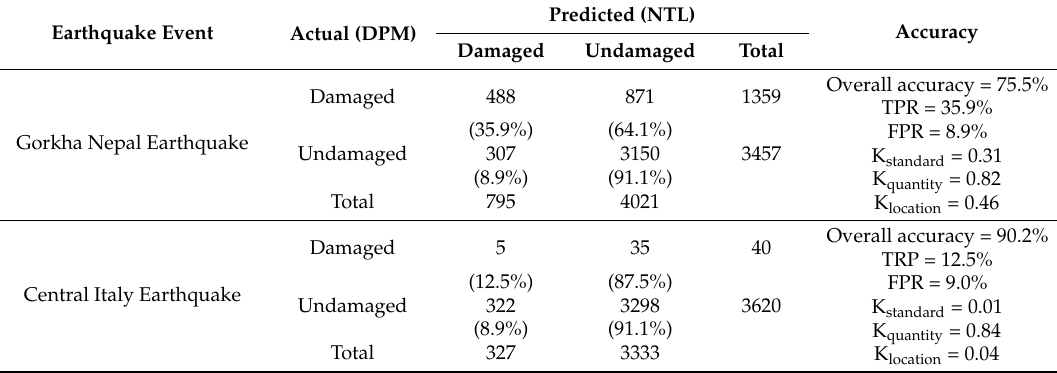
Table 3. The confusion matrices and accuracy for using nighttime light (NTL) images to detect areas of damage after earthquake events.